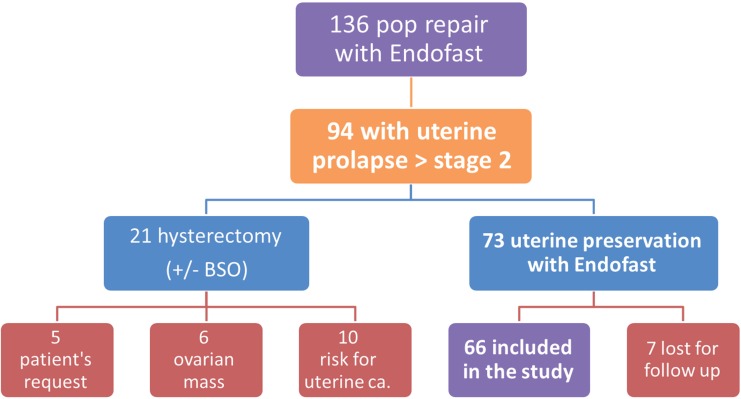
Patient selection for the study.Risk for uterine cancer was consider as a patient with breast cancer, currently under tamoxifen treatment